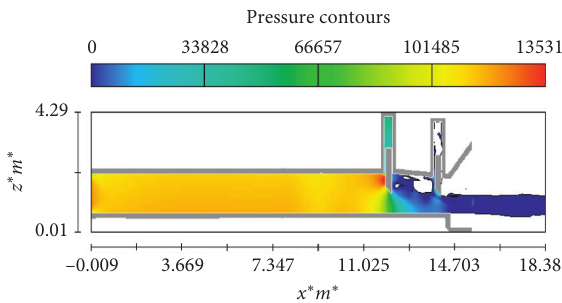
Figure 30: Velocity changes in the branch area for fully closed gate mode and 100% open branch